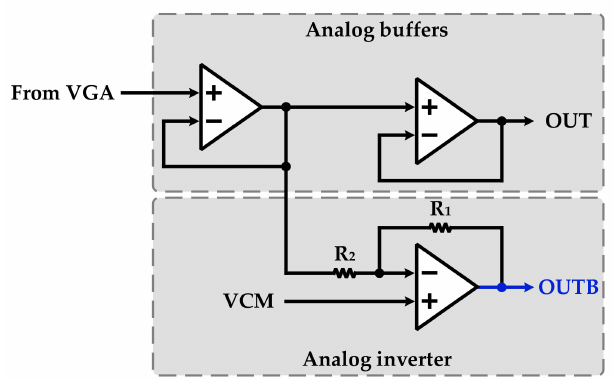
Figure 7. Block diagram of the STOD.